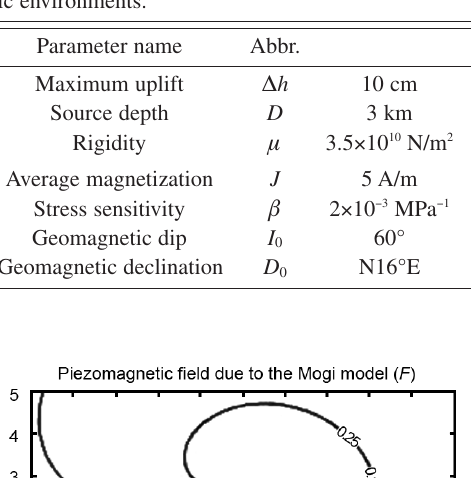
Table I. Parameters of the Mogi model and magnet- ic environments.